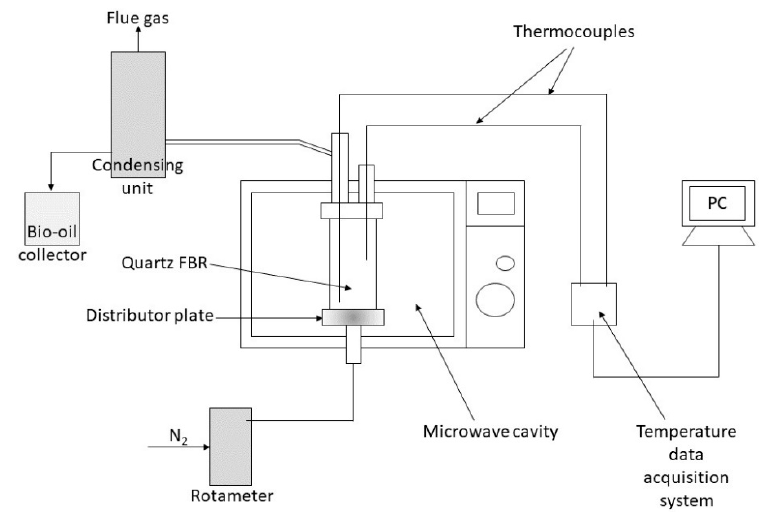
Figure 6. MAP setup used by Salema and Ani (Adapted from [68]).